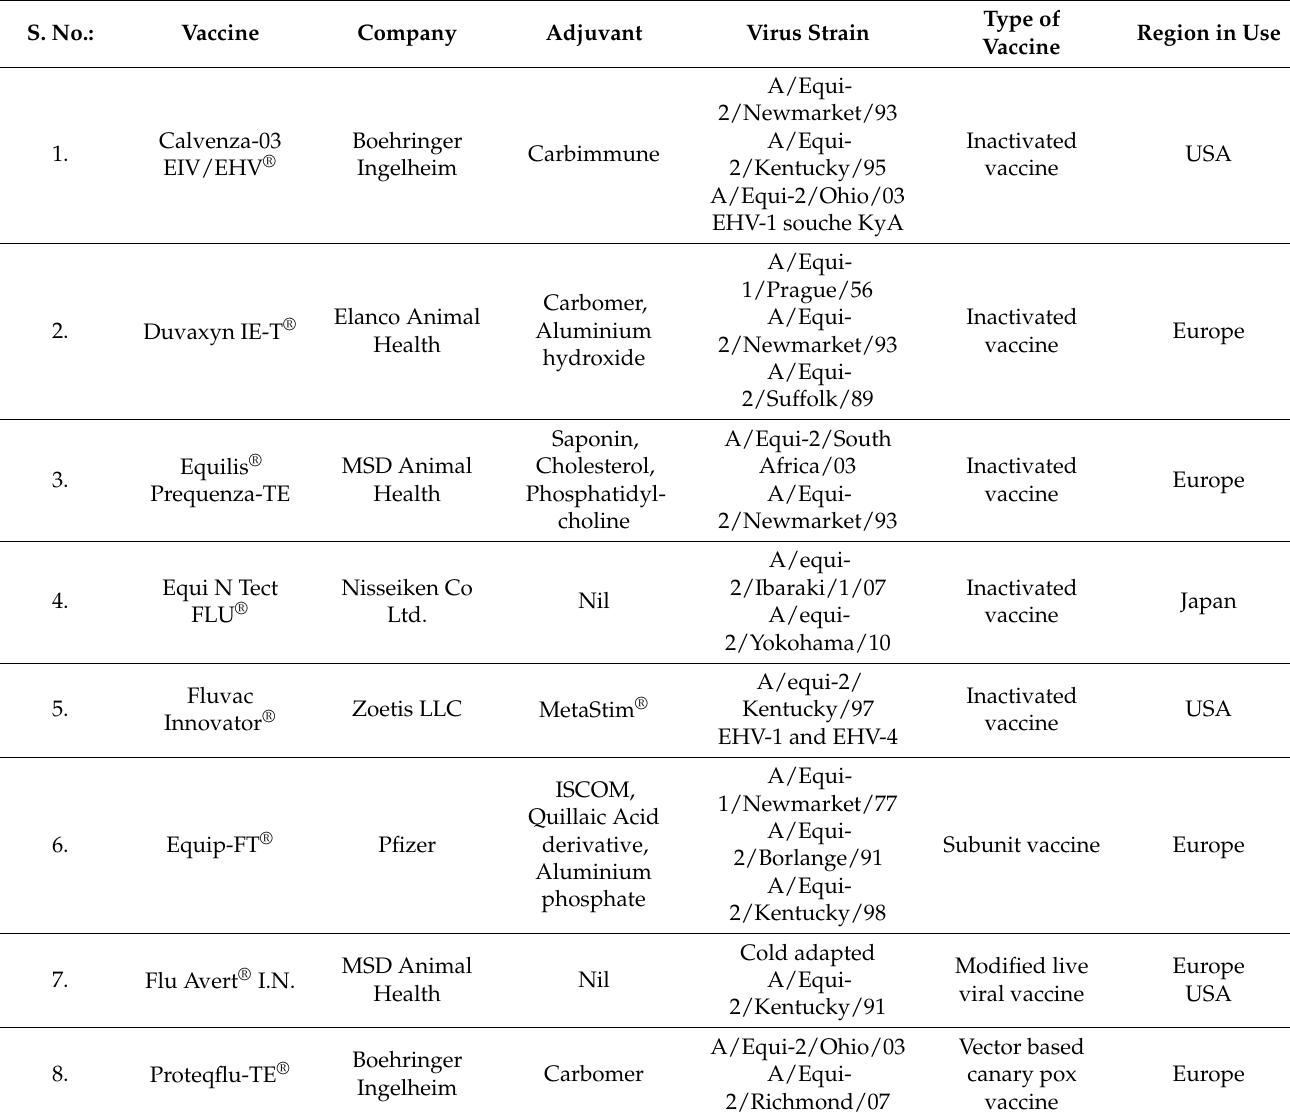
Table 1. Currently available commercial equine influenza virus (EIV)